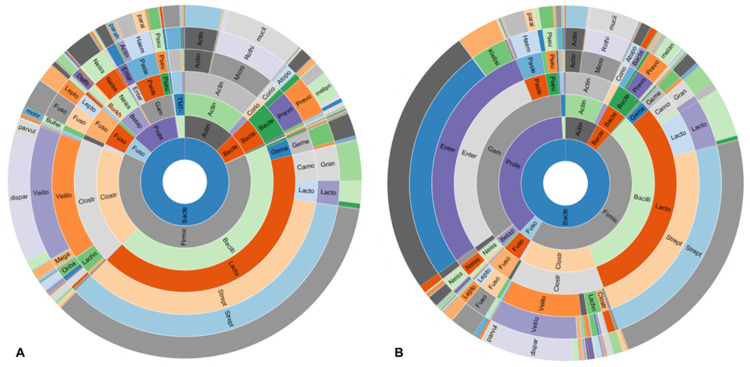
Sunburst representation of the duodenal microbiome in (A) non-SIBO (N = 98) and (B) SIBO (N = 42) subjects.